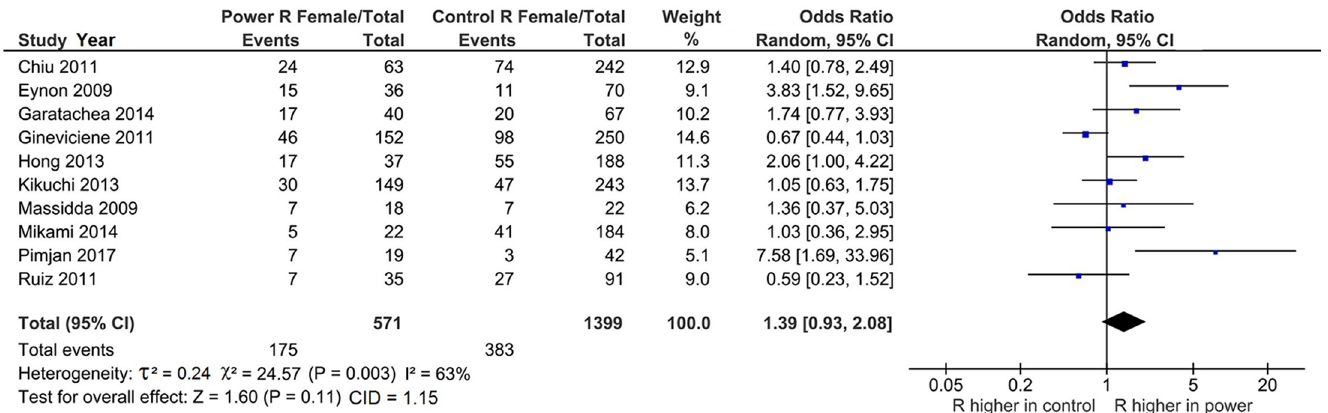
Fig 3. Forest plot of the R allele female effects in the pre-outlier analysis. R: wild-type; CI: confidence interval; P: P-value; χ 2 : chi-square; CID: confidence interval difference.